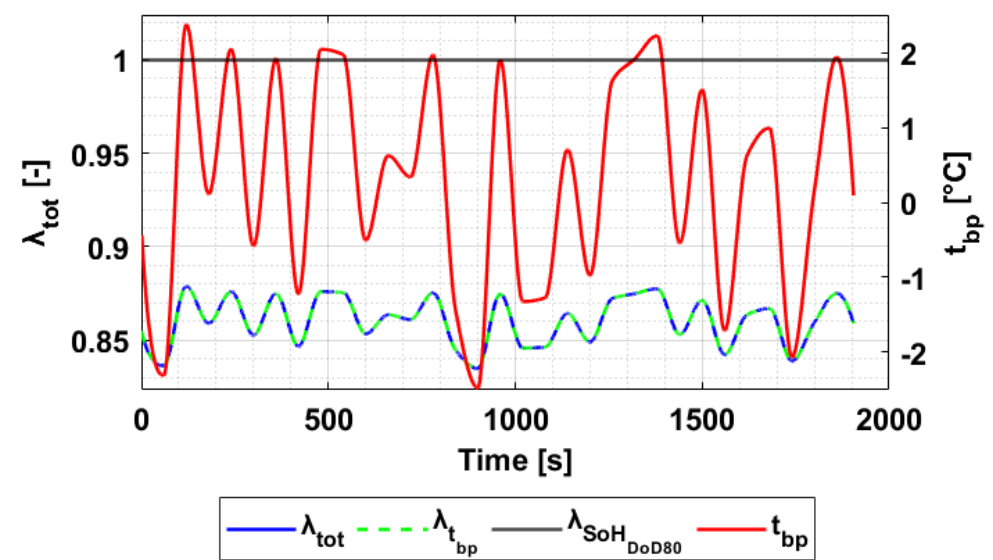
Figure 22. Combined effect of the battery pack temperature and the battery ageing level on λ tot for DM25 in the case of a new battery and DoD80.